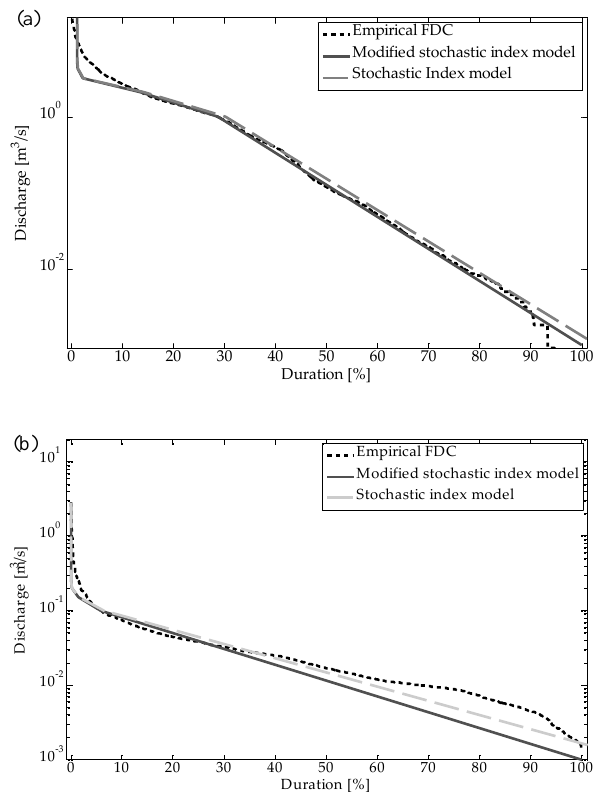
Fig. 8. Semi-logarithmic representation of fitted FDC (Pr( X > x )) for sites n. 5 (a) and n. 3 (b) . The broken black line is the empirical FDC, obtained through the Weibull plotting position, the solid grey line is calculated using the modified stochastic index flow model and the broken bright grey line is FDC calculated using the standard stochastic index flow model.